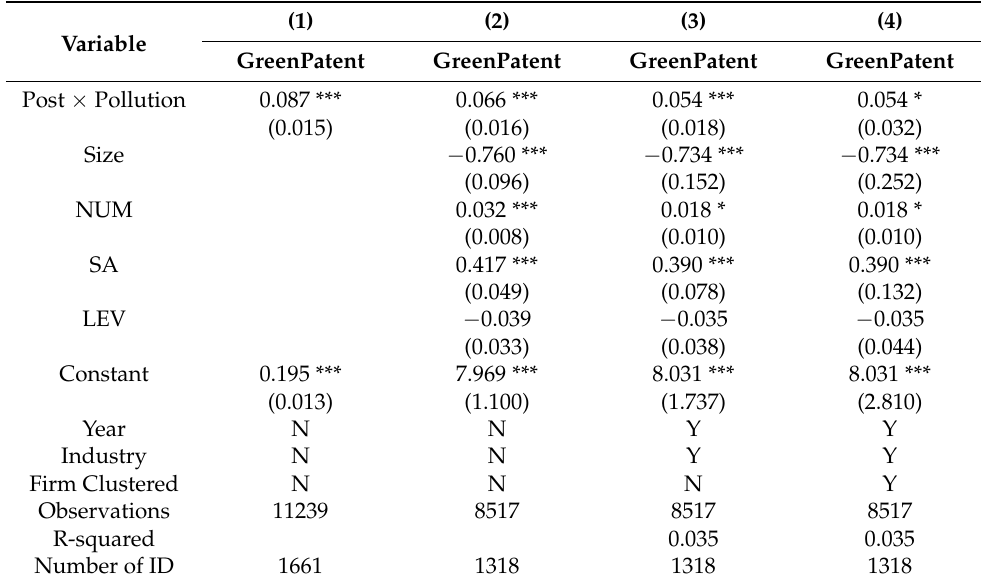
Table 3. Environmental regulation and corporate green